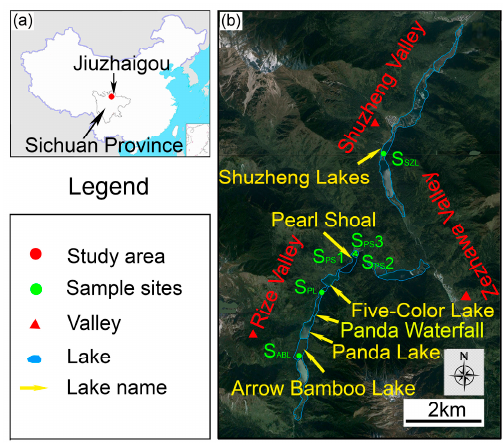
Figure 1. Maps showing: ( a ) The location of Jiuzhaigou; ( b ) The positions of the main tufa-depositing lakes and the approximate installation point of each substrate.